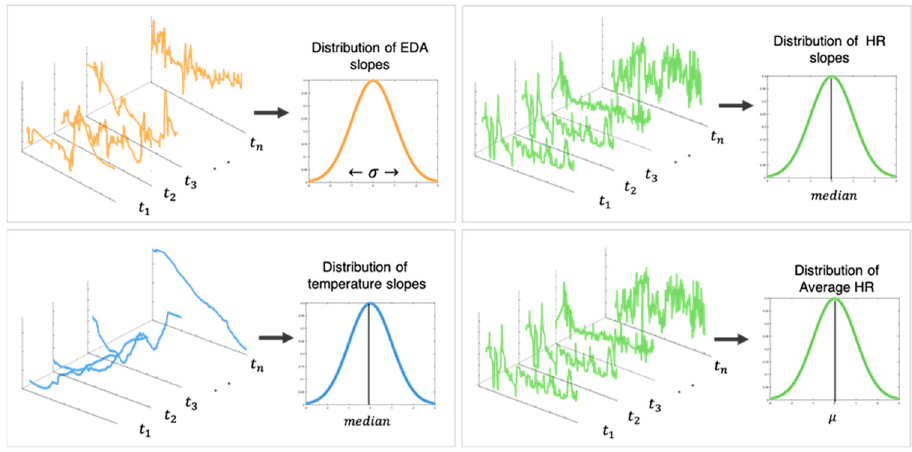
Figure 2. The average slopes of the EDA, HR, and skin temperature were computed across 60 s sliding windows in each forest activity segment. Features extracted for each forest activity segment: standard deviation of the EDA slopes, median of the temperature and HR slopes, mean HR.